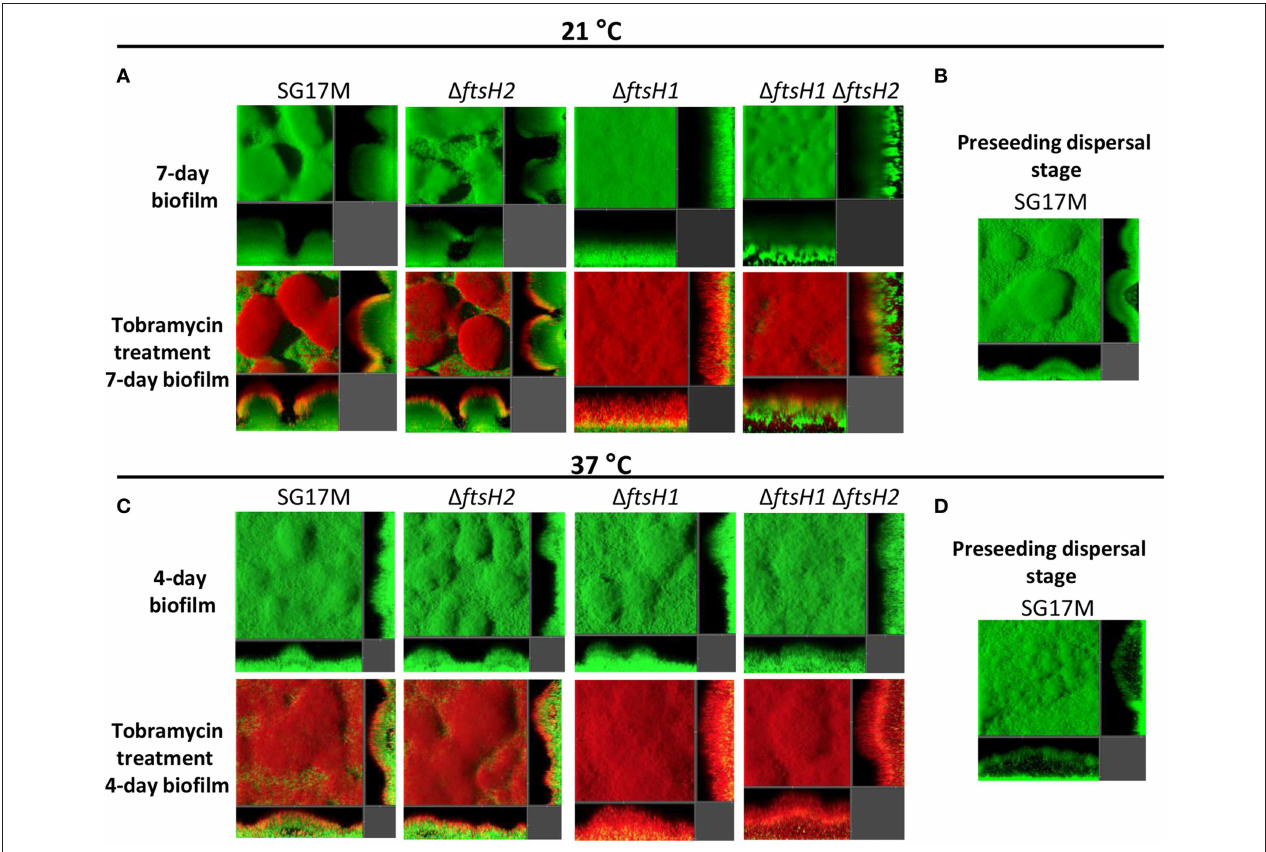
FIGURE 4 | Contribution of P. aeruginosa SG17M ftsH gene products to biofilm architecture and tobramycin tolerance in a microfluidic flow cell chamber biofilm. (A) Biofilm formation of P. aeruginosa SG17M and ftsH mutants at 21 ◦ C after 7 days (top panel) and application of tobramycin for 20h on the mature 7-day old biofilm (bottom panel). (B) Preseeding dispersal stage of SG17M at 21 ◦ C. (C) Biofilm formation of SG17M and ftsH mutants at 37 ◦ C after 4 day (top panel) and application of tobramycin for 20h on the mature 4-day old biofilm (bottom panel). (D) Preseeding dispersal stage of SG17M at 37 ◦ C. Strains are tagged with GFP and propidium iodide (PI) was used to stain dead